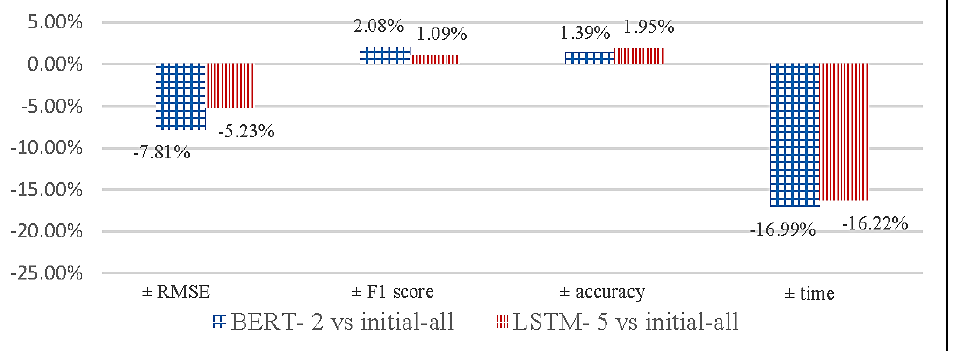
Figure 14. Percent variations averages experienced by the four models, per indicator, and for every quality inspector with Kindle Store